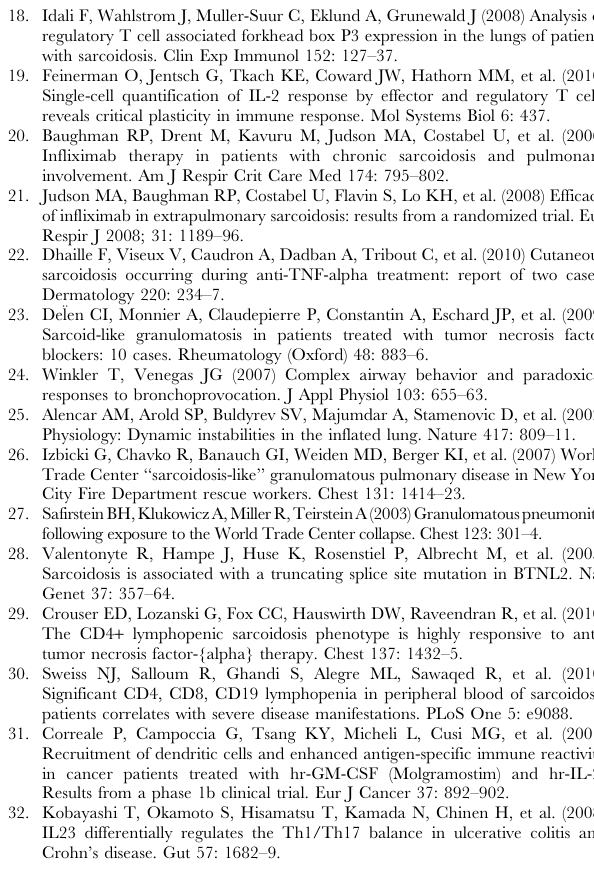
Figure S1 Steady state of T ( T s) as a function of fT (from Eqn 2) for two values of h T ( h T=1 for the black curve, and h T= 0.5 for the gray curve). Other parameter values: bT = 0.05, eT = 1. (TIF) Figure S2 The detailed immune network model, show- ing numbered interactions representing the model differential equations for each cell [T effector (T), Treg (R), Macrophage (M)] or molecule (TNF a , IFN c , IL-2), represented by Eqns 3–8. Arrows mean ‘‘upregulate’’ or activate while hammerheads mean ‘‘downregulate’’ or inhibit. (TIF) Text S1 Supporting information demonstrating a bis- table switch between low and high Teff steady states predicted by the model.